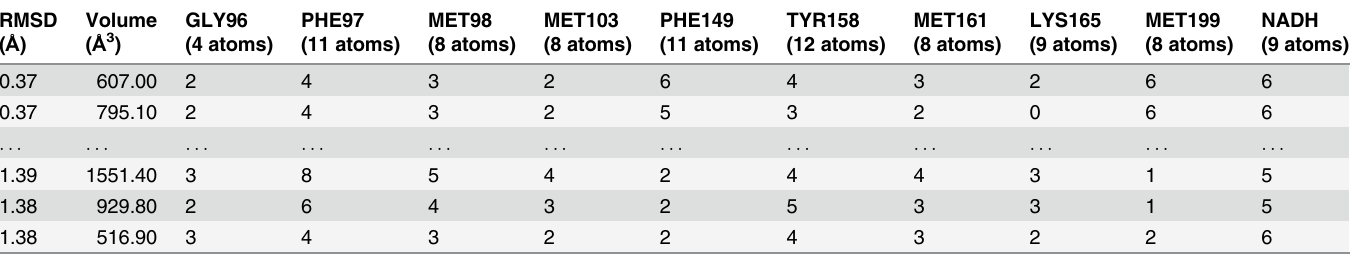
Table 1. Fragment of the Cavity Attributes data set used for clustering the MD trajectory. The first line labels the substrate-binding cavity features. The number below each residue indicates the maximum number of heavy atoms it can hold.